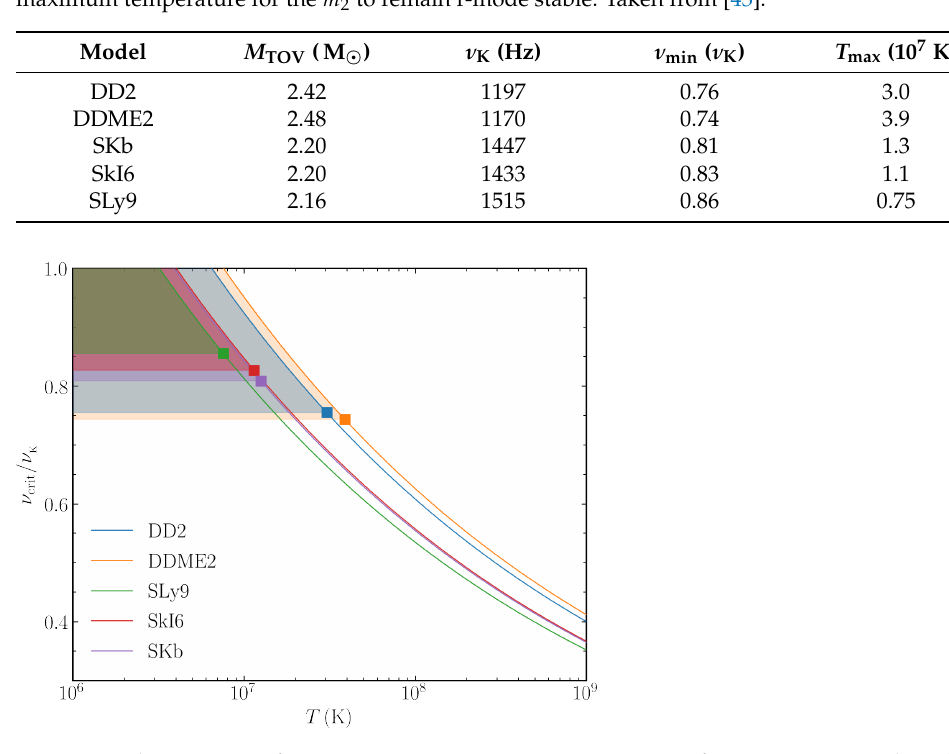
Figure 16. The minimum frequency ν min to support a neutron star of mass 2.50 M (cid:12) is plotted as a horizontal line in the frequency–temperature plane where the r-mode stability boundary for each EOS is also shown. Their cross point is marked with a diamond indicating the maximum temperatures T max below which neutron stars remain r-mode stable. Taken from